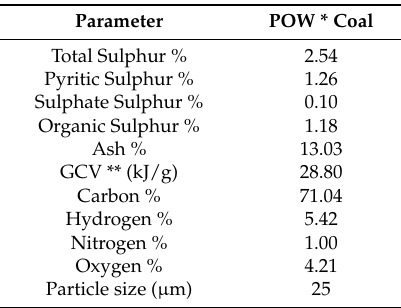
Table 1. Analysis of the untreated coal.